Question: Express in one sentence what the figure is showing.
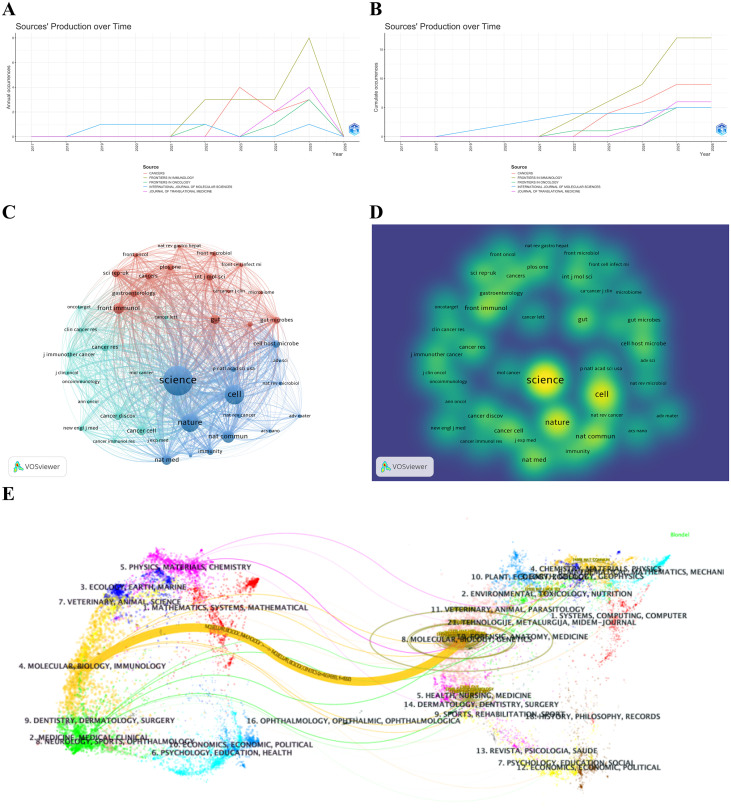
Answer: Journal publication trends and co-citation analysis. (A) Annual publication trends of core journals. (B) Cumulative publication trends of core journals. (C) Co-citation network of journals with at least 100 co-citations (N = 43). Node size is proportional to co-citation frequency. Edge thickness represents co-citation strength. Node colors indicate distinct co-citation clusters identified. (D) Density visualization of co-cited journals. Higher density (yellow) indicates stronger co-citation relationships, concentrated around Nature , Science , and Cell . (E) Dual-map overlay of journals related to the publications. Colored paths indicate citation flows between citing journals (left) and cited journals (right).